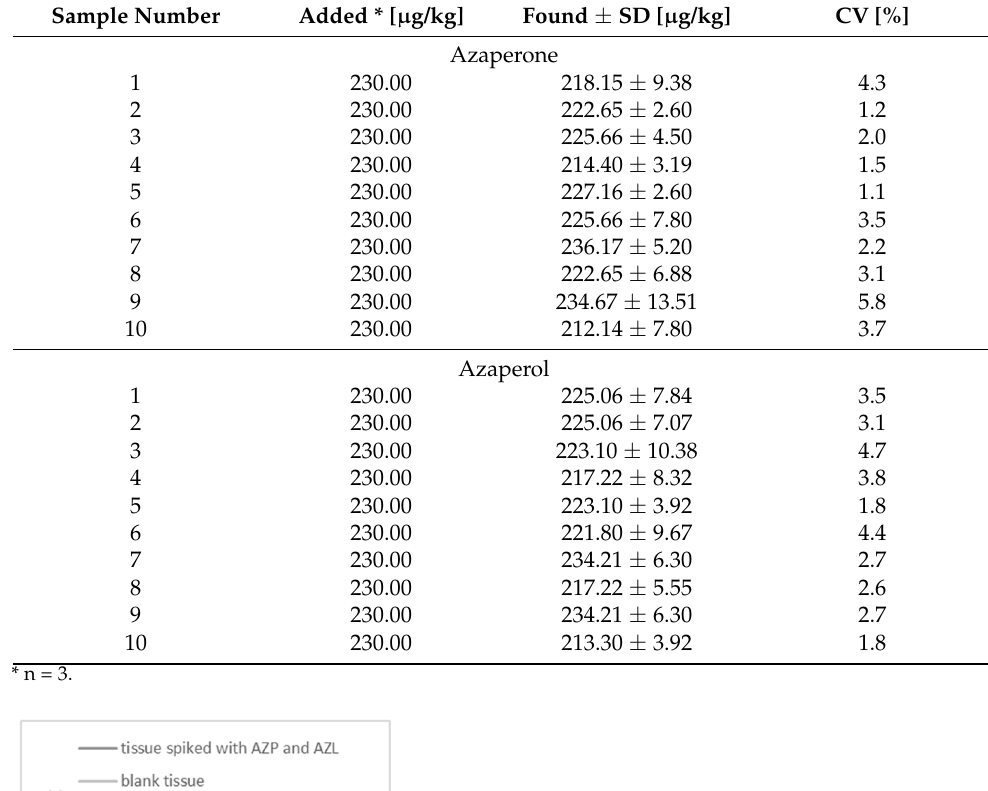
Table 5. Determination of AZN and AZL in tissues (livers, kidneys)—results.